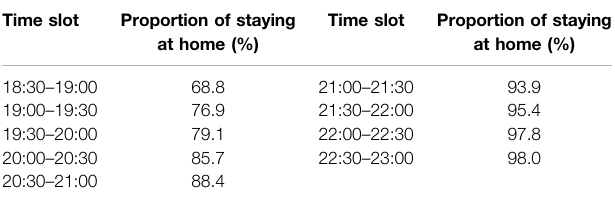
TABLE 3 | Time distribution of staying at home in the summer electricity peak